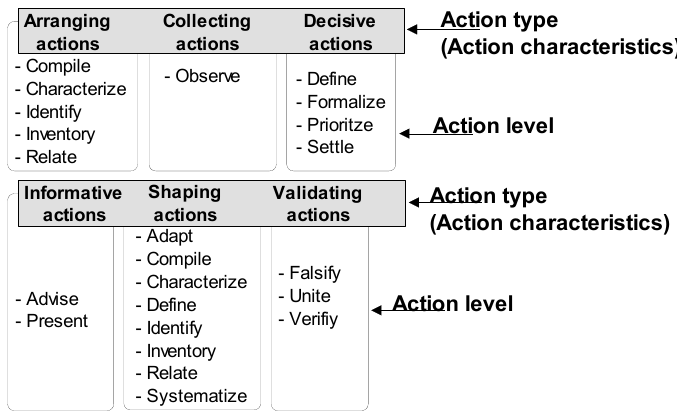
Figure 7. Grouping of actions into action level and action